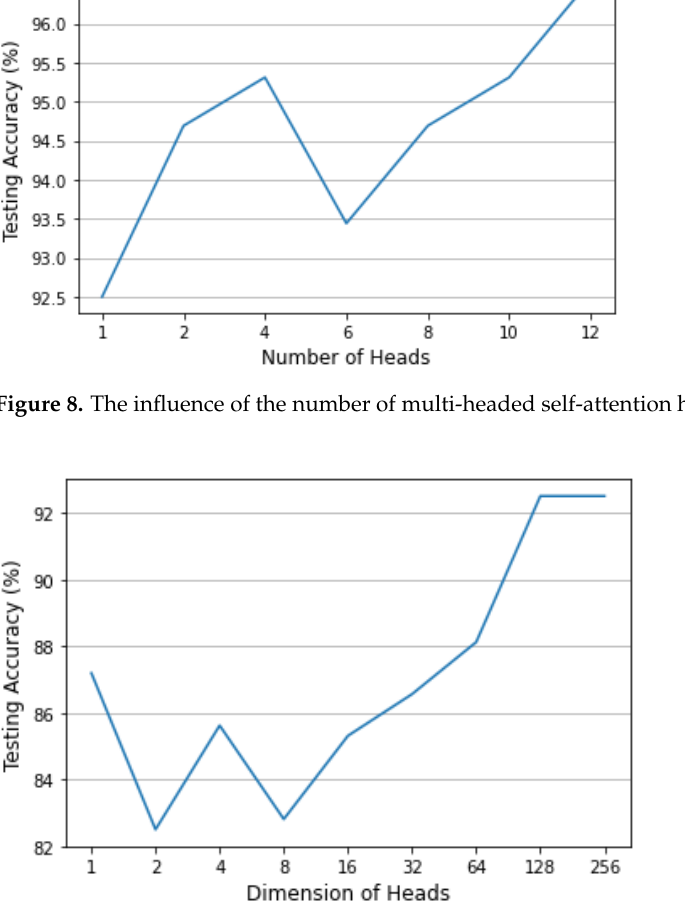
Figure 9. The influence of the dimension of the multi-headed self-attention heads. Finally, the output dimensions of the feedforward layer are investigated with the parameters of (4, 128, 4, 64). The results are shown in Figure 10. It can be observed that the dimensions have a great influence on the testing accuracy. To be specific, the minimum accuracy is about 8 percentage points less than the maximum accuracy.